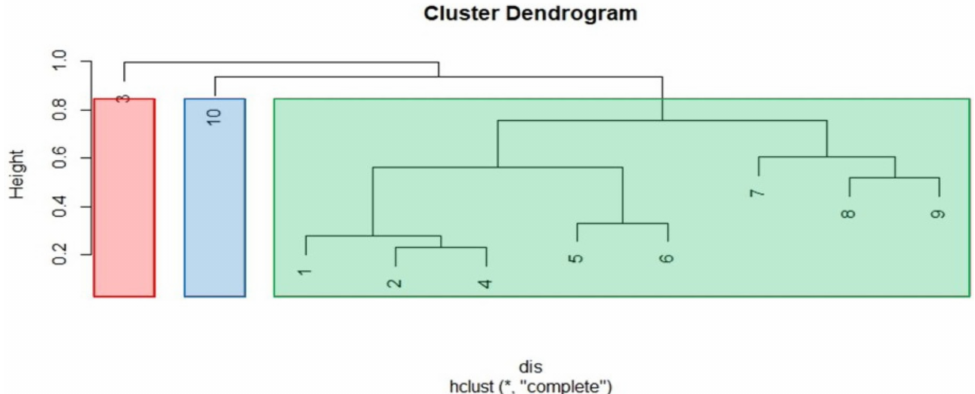
Figure 4. Cluster dendrogram applied to the “hclust” function in Vegan to perform hierarchical analysis with the cover degree of the plant. The “complete” option was used to express a compact cluster. The clusters in the red zone were areas occupied by Tripterygium regelii and Trifolium pratense . The clusters in the blue zone were areas dominated by Acer pseudosieboldianum and Stephanandra incisa . Green areas were inhabited by Carex callitrichos var. nana ; 1–10 denote the site